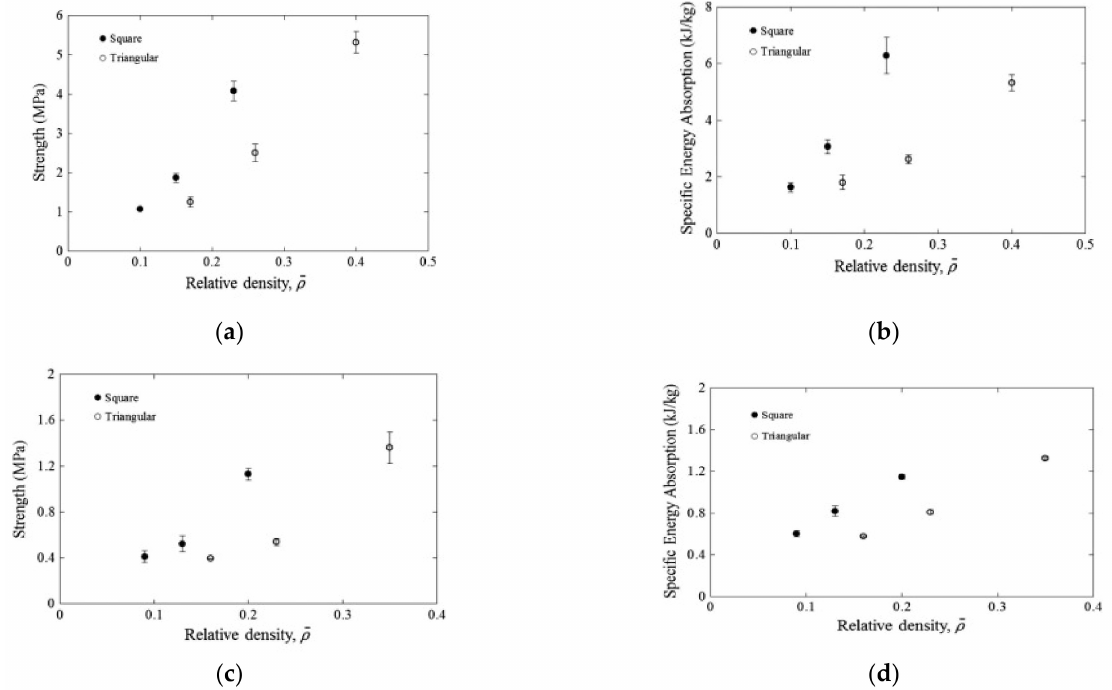
Figure 6. The compression strength and energy absorption of ( a , b ) flax/PP and ( c , d ) flax/PLA interlocking structures